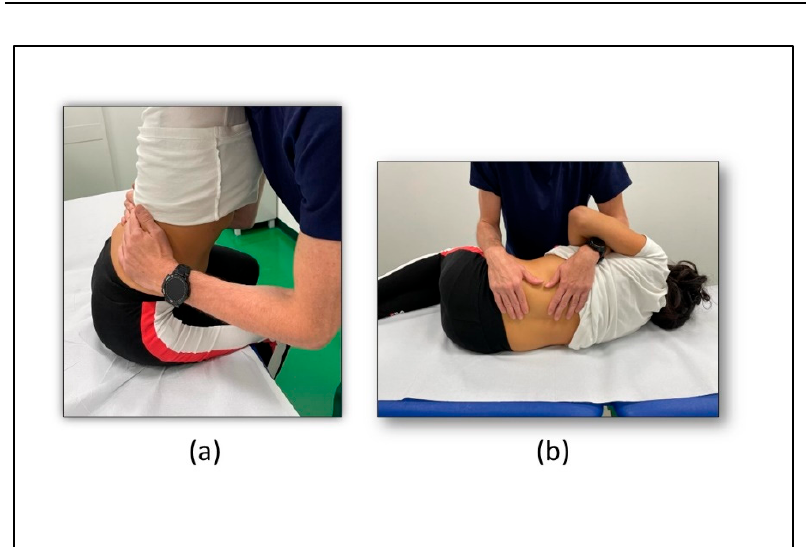
Figure 3. Spinal mobilization intervention exercises. ( a ) Spinal mobilization exercise 1; ( b ) Spinal mobilization exercise 2.